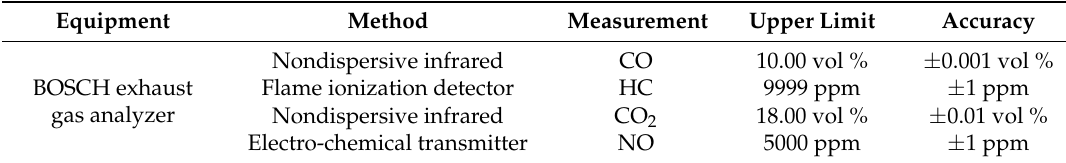
Table 4. Detailed specifications of the exhaust gas analyzer.